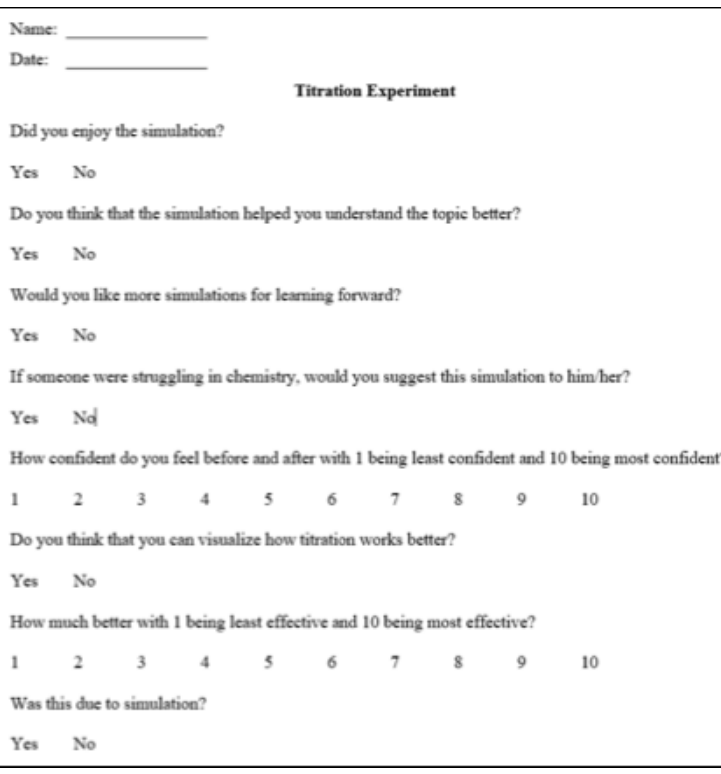
Figure 6. Student survey for the F ormation of Hydrogen